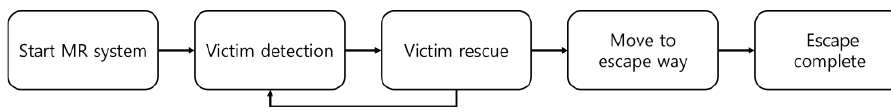
Figure 3. Simulated rescue scenario.